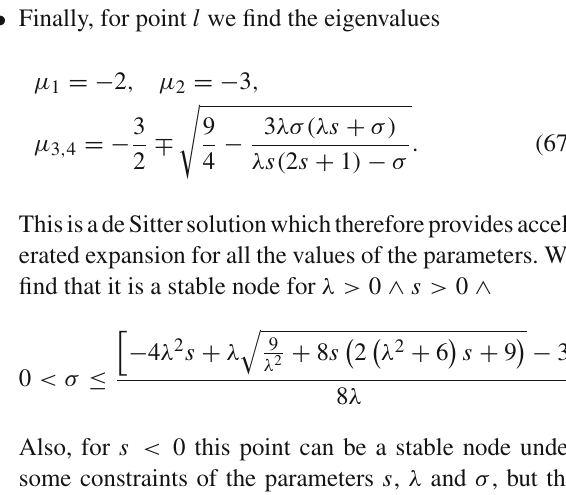
during the scaling radiation/matter regimes, for the evolution curves a R → g M → k , and b R → g M → k , we have applied the constraints on the fractional energy density parameters ( r ) ( m ) , Ω , coming from the Physics of of dark energy, Ω de de ( r ) < 0 . 045 [127], and Big Bang Nucleosynthesis (BBN), Ω de ( m ) < 0 . 02 (95% CL), CMB measurements from Planck, Ω de at redshift z ≈ 50 [125]. For example, in Fig. 1, during the ( r ) ≈ 1 . 78 × 10 − 4 scaling radiation era b R , we obtain Ω de (solid blue line), and during the scaling matter era g M , we ( m ) ≈ 1 . 35 × 10 − 4 (solid blue line), and Ω ( m ) ≈ find Ω de de 1 . 37 × 10 − 4 (dashed blue line), at redshift z = 50.